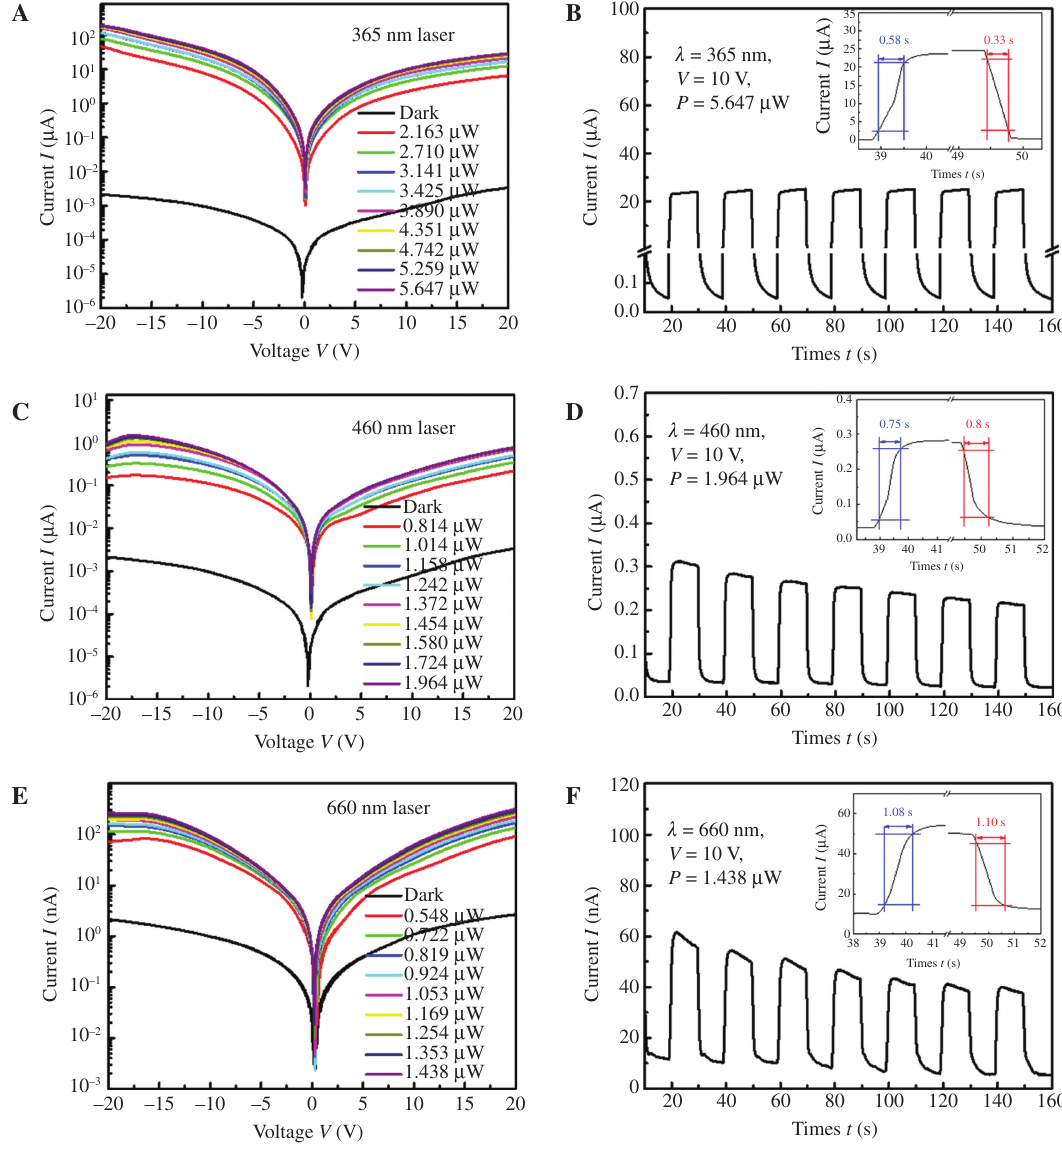
/SiC photodetector. Figure 4: Photoresponse characteristics of MoS 2 Photoresponse ( I-V ) characteritics of MoS /SiC under (A) 365 nm, (C) 460 nm, and (E) 660 nm incident light with different light powers. 2 Typical time-dependent current curve of the photodetector at bias of 10 V under (B) 365 nm, (D) 460 nm, and (F) 660 nm. The insets show the corresponding rise time and fall time for fabricated MoS /SiC 2